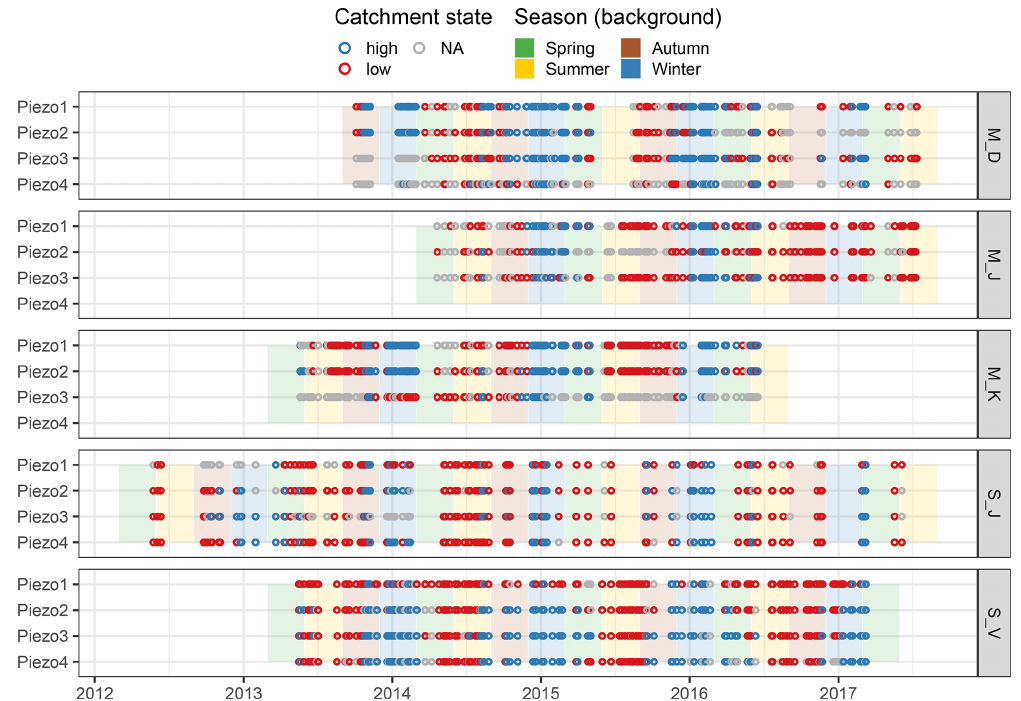
Figure 12. Catchment states at the beginning of events. In contrast to Fig. 6, it shows whether or not the groundwater levels are above (high/blue) or below (low/red) the locally defined groundwater threshold levels. Complete , partial and dry events are included; all other events are shown in grey (NA, not